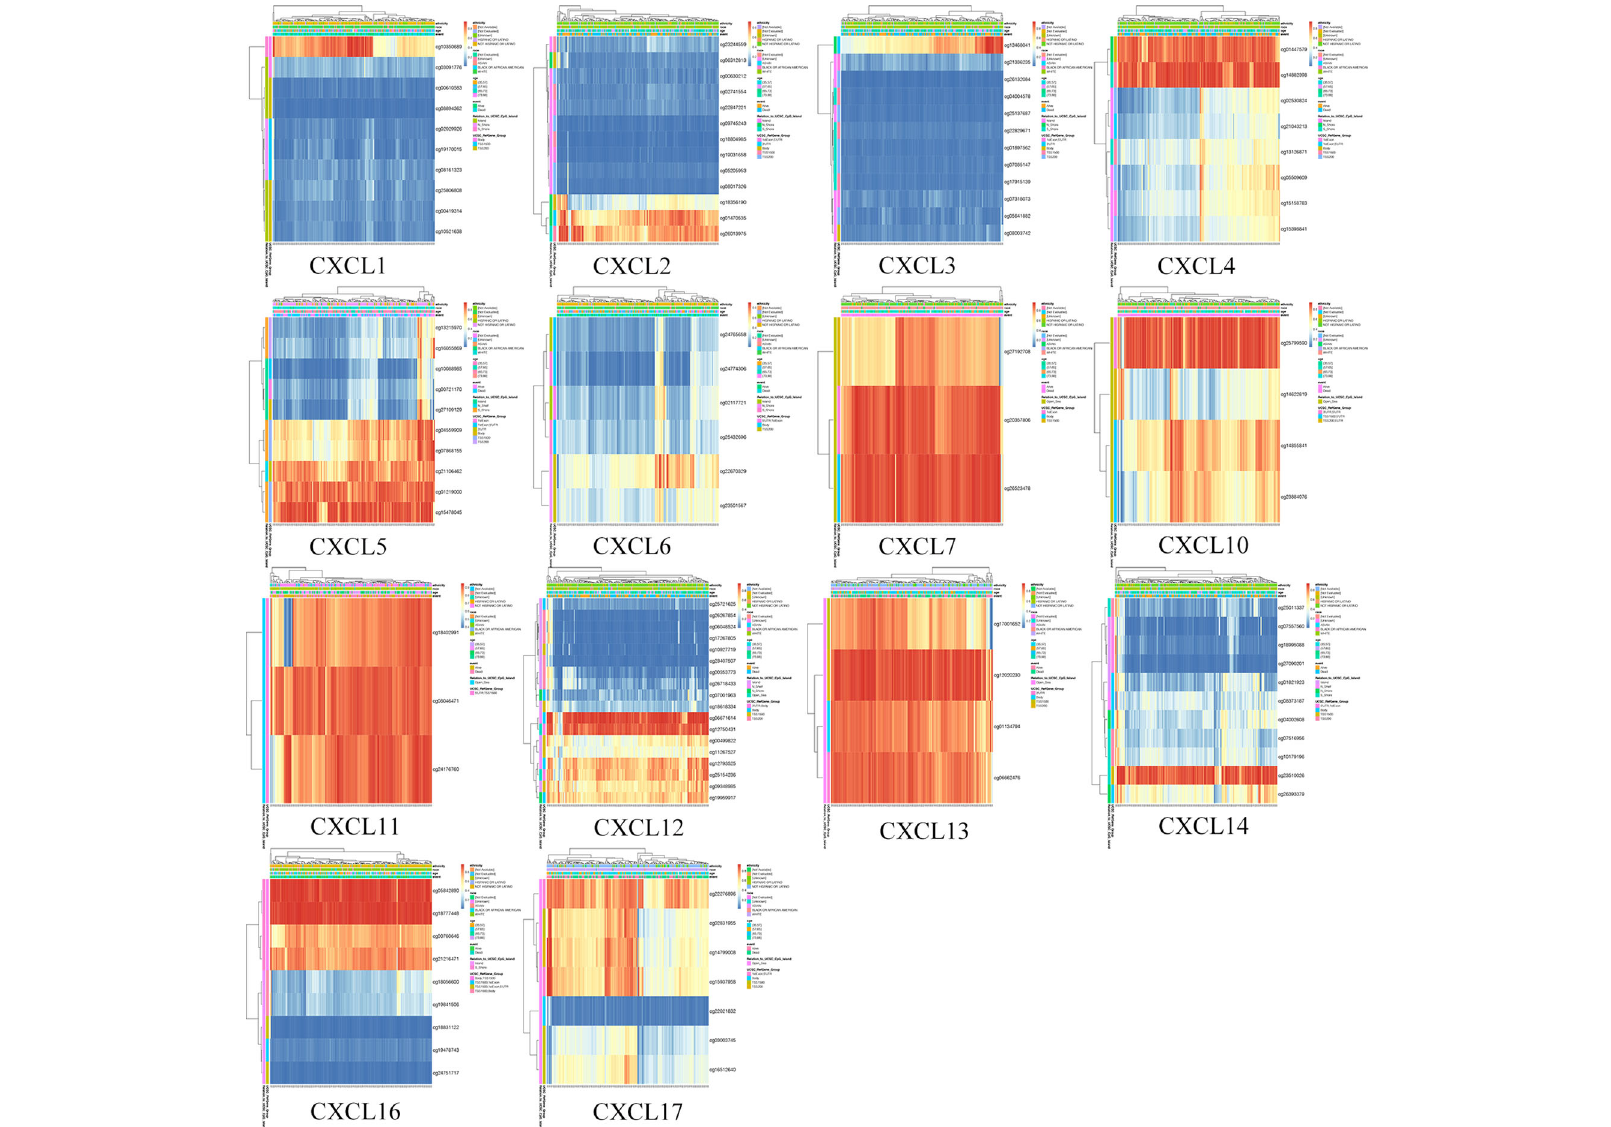
FIGURE 10 | The heatmap of DNA methylation level of single CXC chemokine (MethSurv). High expression (red); low expression